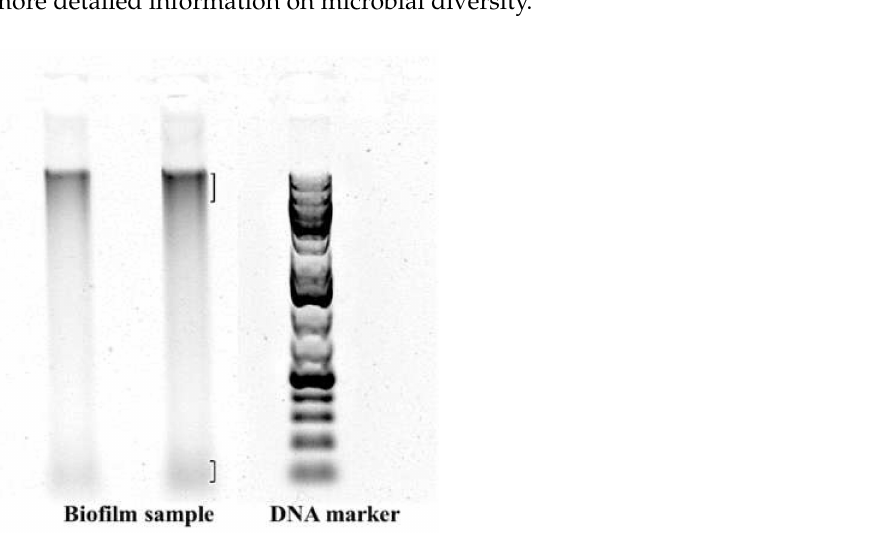
Figure 10. Denaturing gradient gel electrophoresis fingerprints of microbial communities of